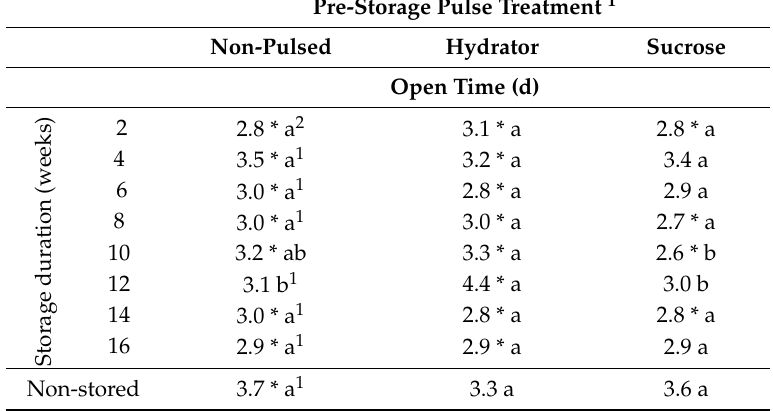
Table 3. Mean flower open time (d) for Paeonia lactiflora cultivar Festiva Maxima (FM) in response to pre-storage pulse treatments and storage duration in Exp2 independent of storage temperature (0.7, − 0.6 ◦ C). Grand mean bud time was 1.4